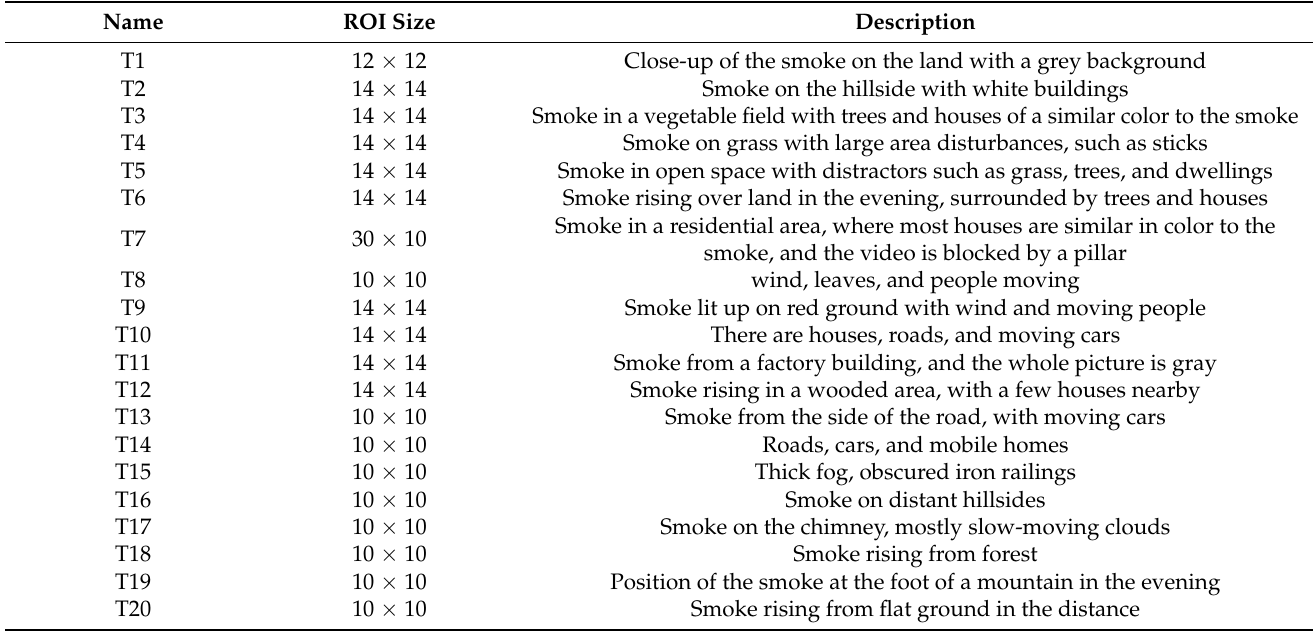
Table 1. Descriptions of the videos used for the